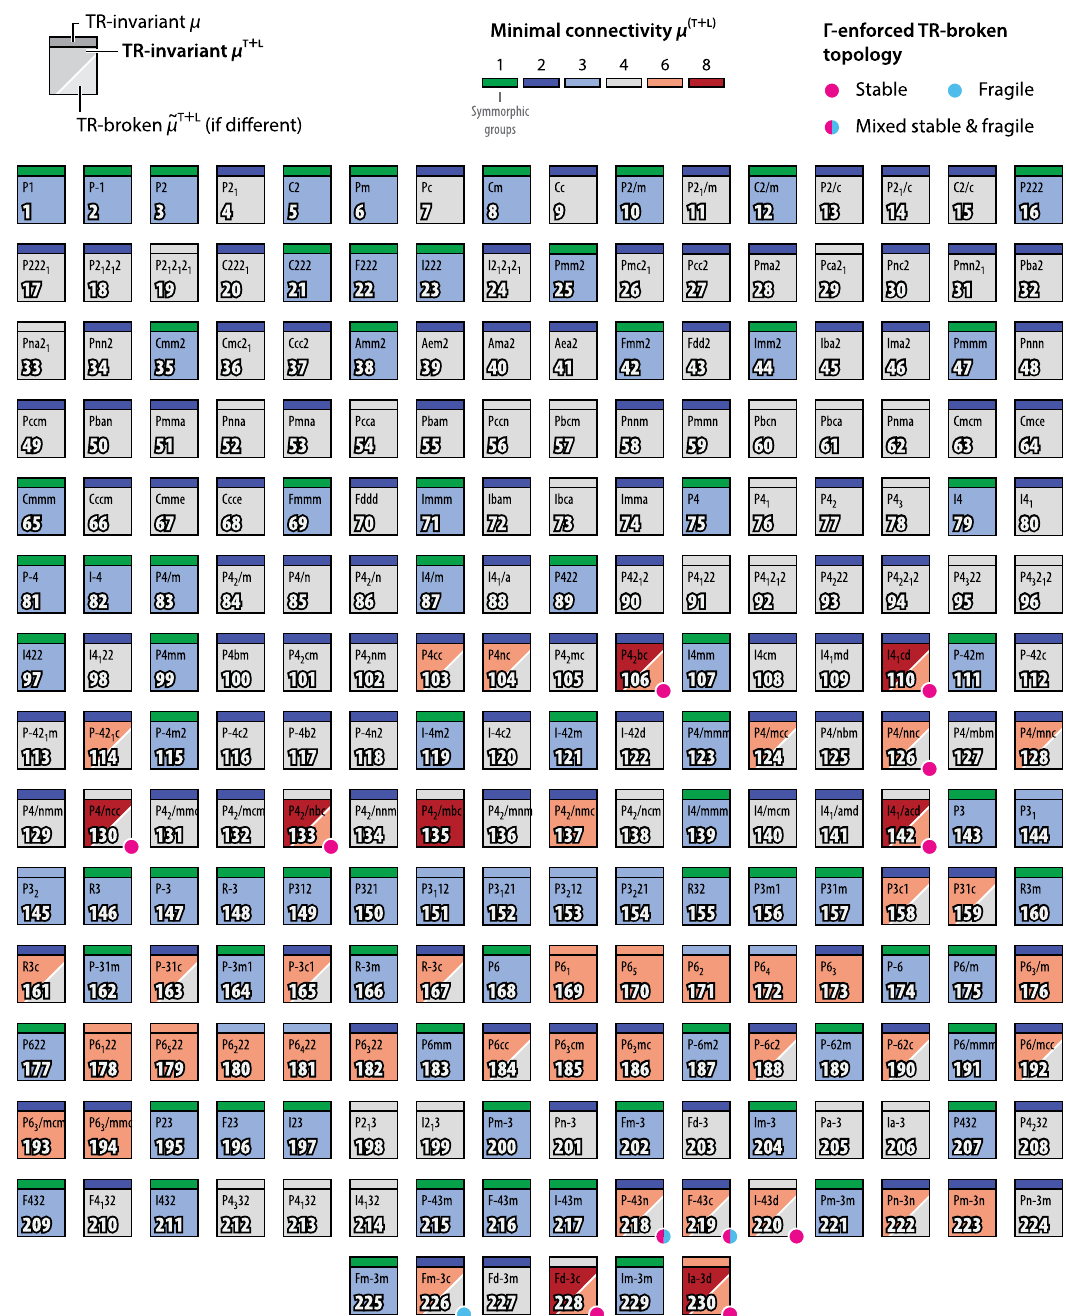
FIG. 5. Minimum phononic and acoustic band connectivity below the first gap and associated Γ -enforced topology. Conventions are as in Fig.